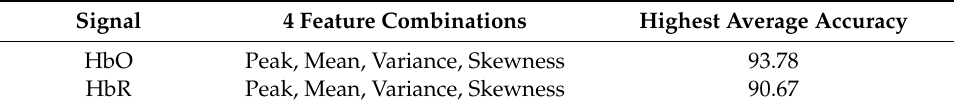
Table 5. The highest classification accuracy of the 4-feature